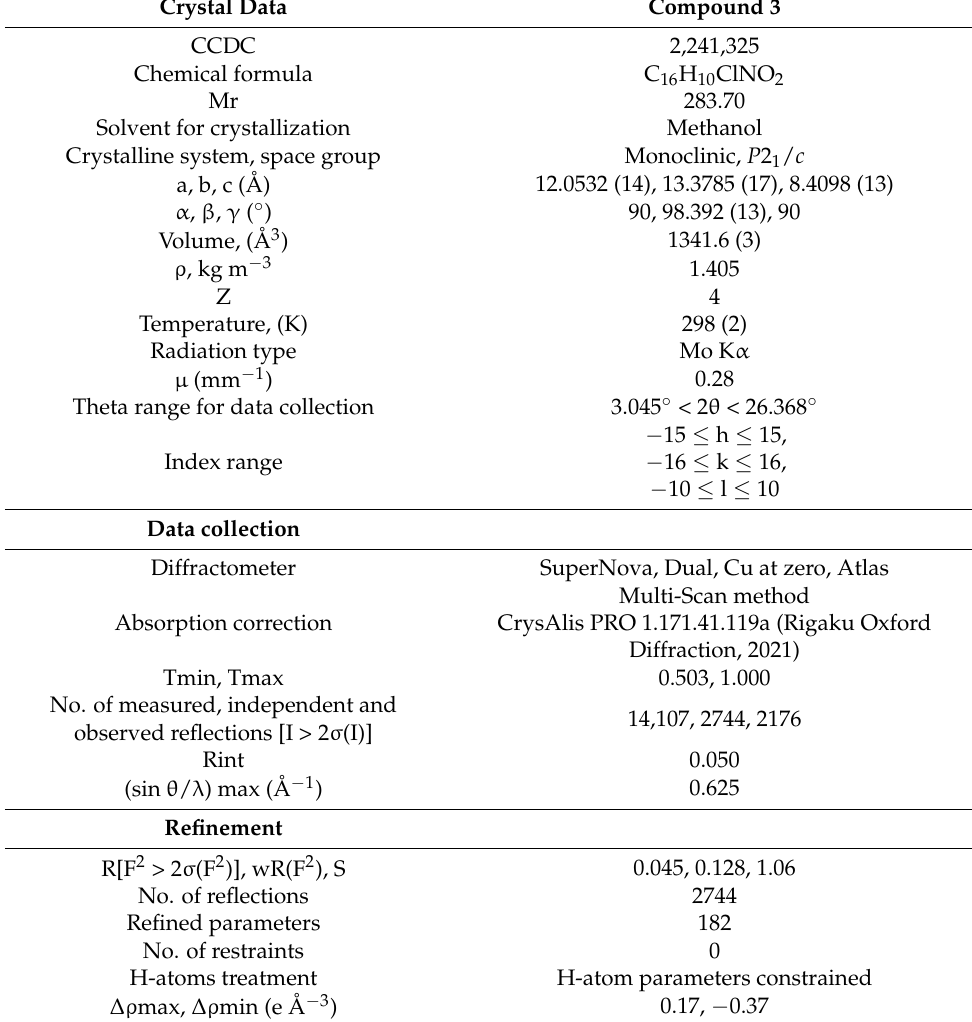
Table 1. Crystallographic data of compound 3